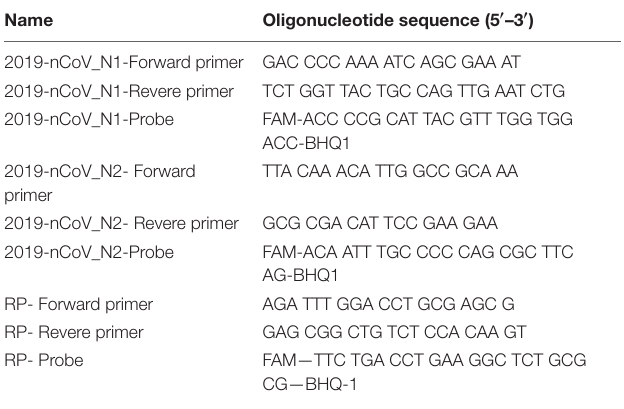
TABLE 1 | Primers and probes for N1, N2, and RNase P (RP) (Centers for Disease Control and Prevention [CDC],